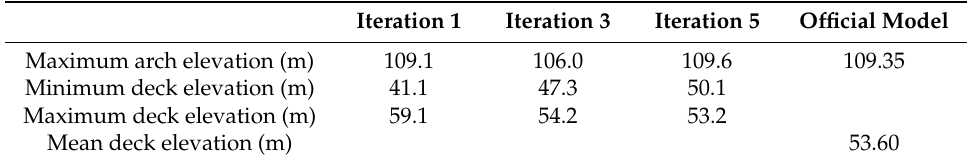
Table 3. Key parameters of the estimated bridge structure from iterations 1, 3, and 5 compared with the bridge model data (only direct measurements are listed).